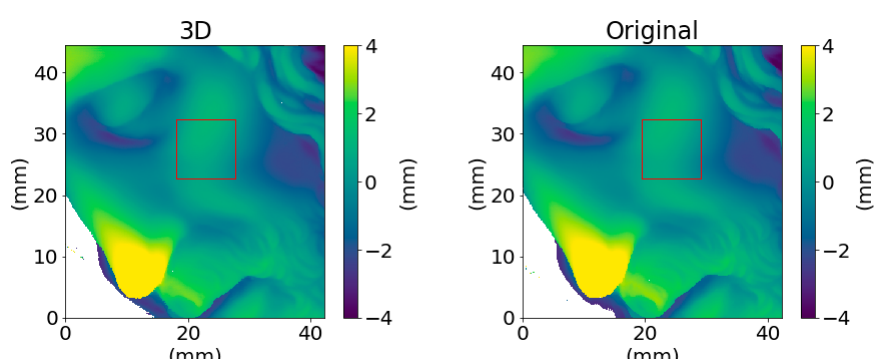
Figure 11. Height map of the 3D printed replica and original object acquired by the microprofilometer. The red areas highlight the smaller ROIs used to compare the texture